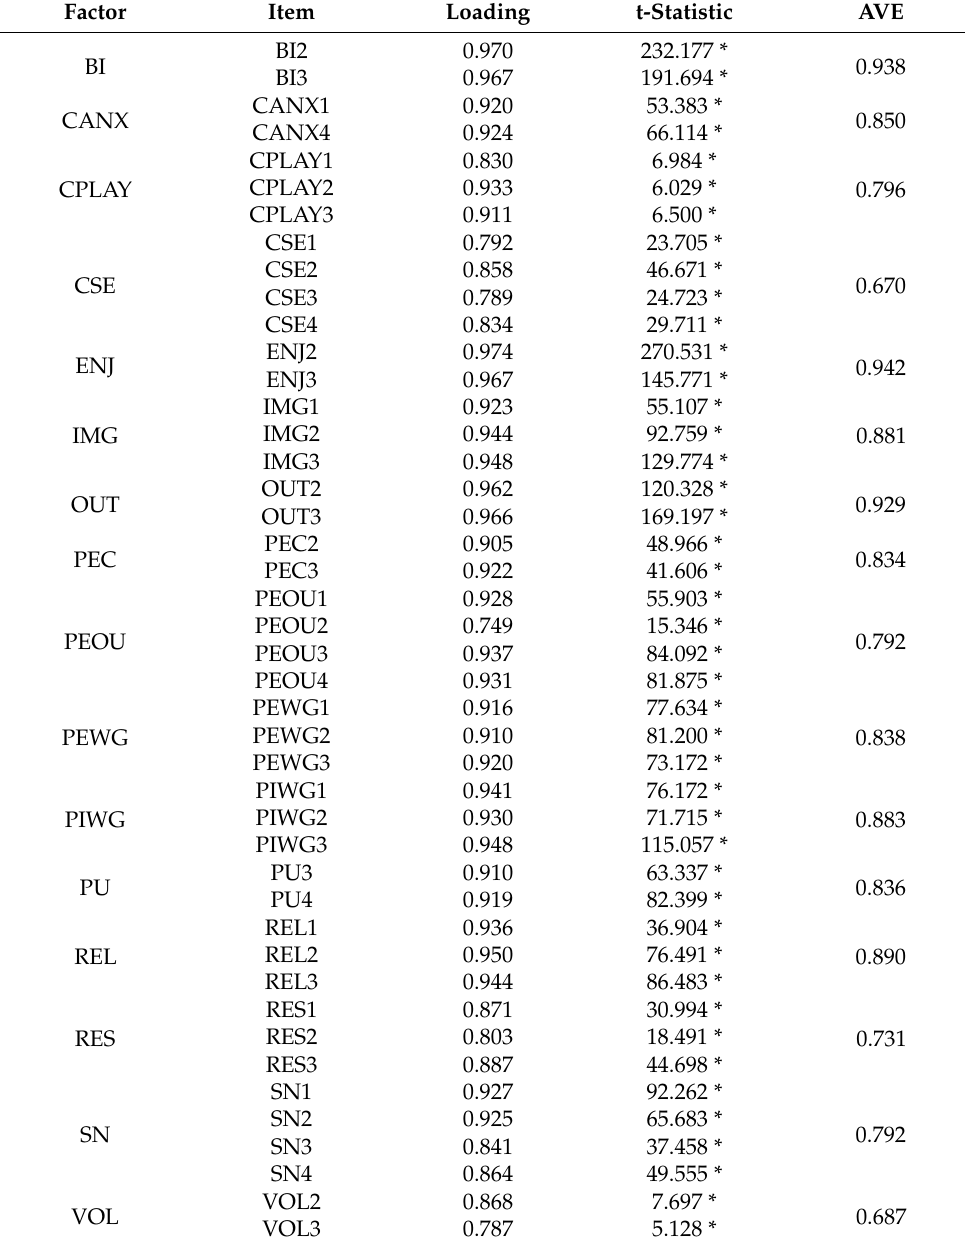
Table 2. Summary of Convergent Validity